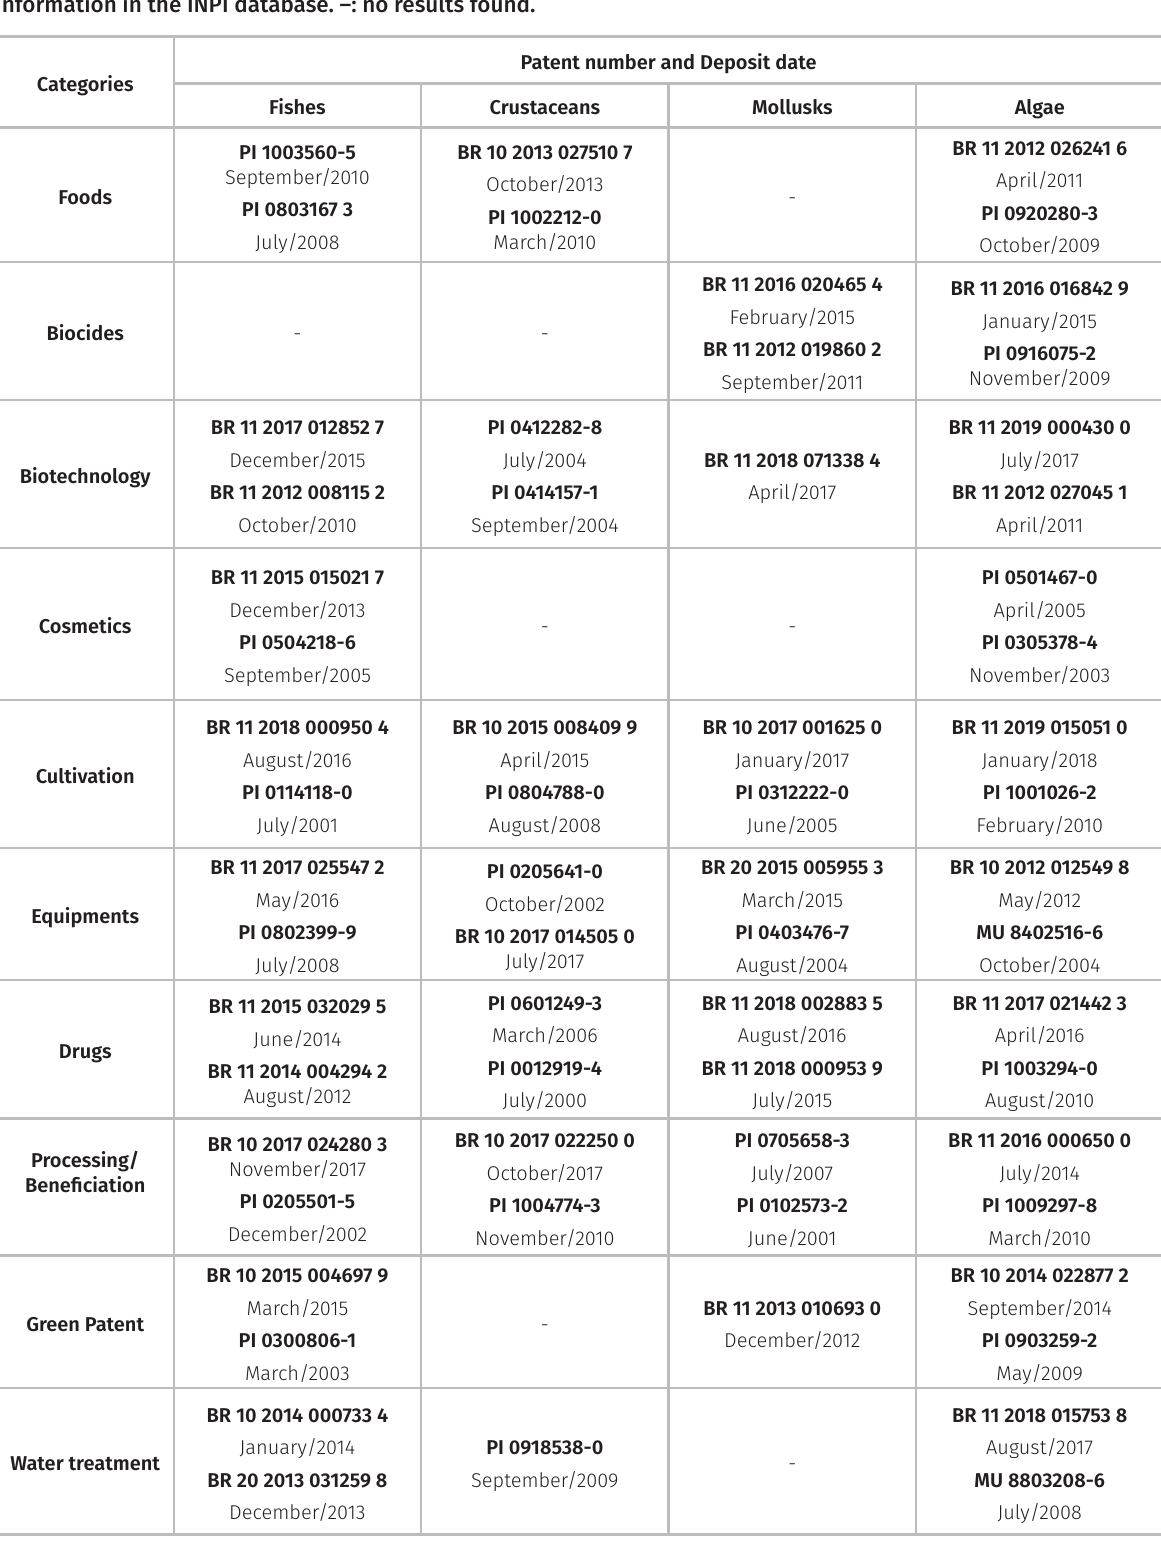
Table I. Information about the areas of application of the main patents identified during the collection of information in the INPI database. –: no results